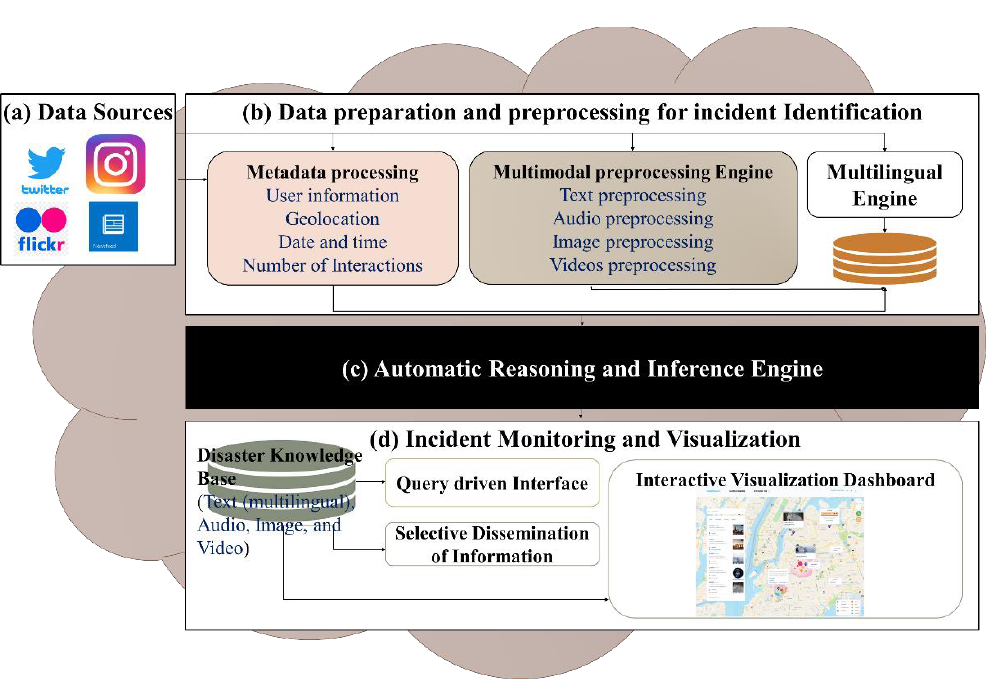
Figure 1. The components of the social media-based incident detection and monitoring system, and the data visualization architecture.